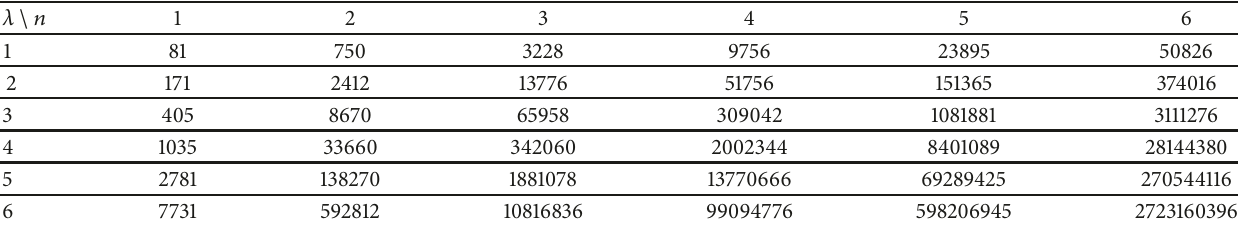
Table 10: Modified Wiener index of 𝑅𝑇𝑆𝐿 .